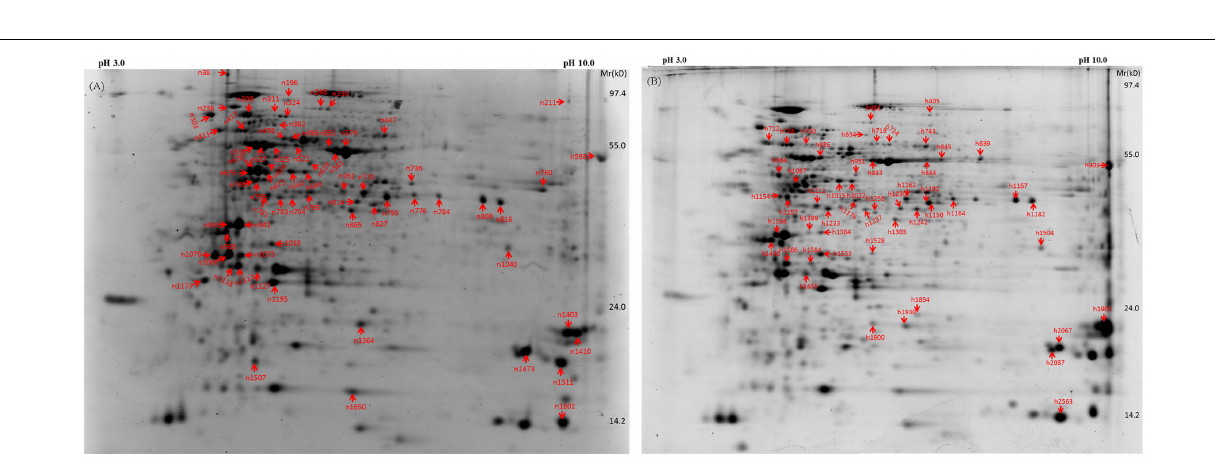
Frontiers in Plant Science |